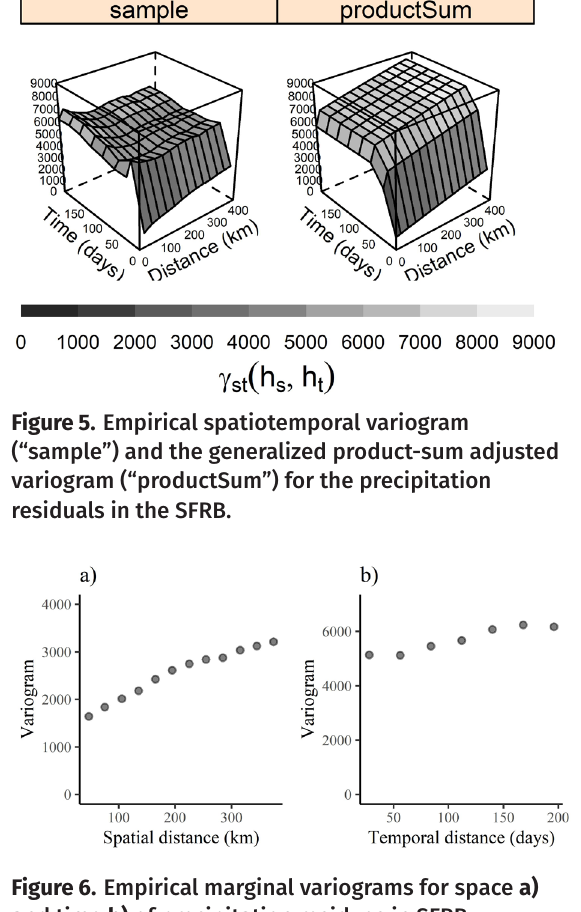
Figure 6. Empirical marginal variograms for space a) and time b) of precipitation residues in SFRB.